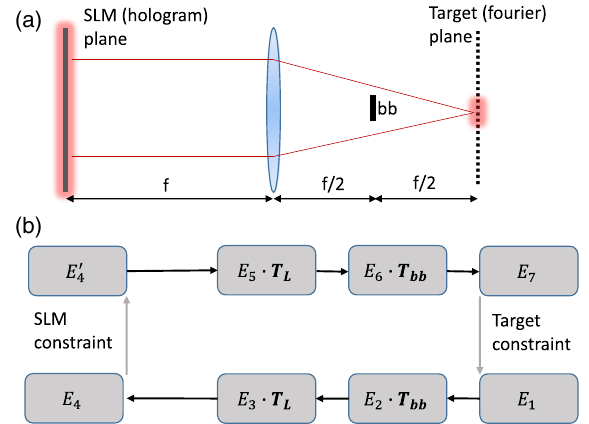
FIG. 6. (a) Optical setup used to generate the desired laser intensity distribution. In order for the electrons to pass through the optical system, a 1.5-mm hole is drilled in the mirrors before and after the interaction plane. To minimize the laser intensity losses at the hole and, hence, to facilitate diffraction around it, a beam block is implemented in the algorithm. (b) The schematic of the adapted iterative GSA. For propagating the electric field from one plane to another, the Fresnel transfer function is used. This allows for introducing additional elements, like beam block, in the iterative algorithm.